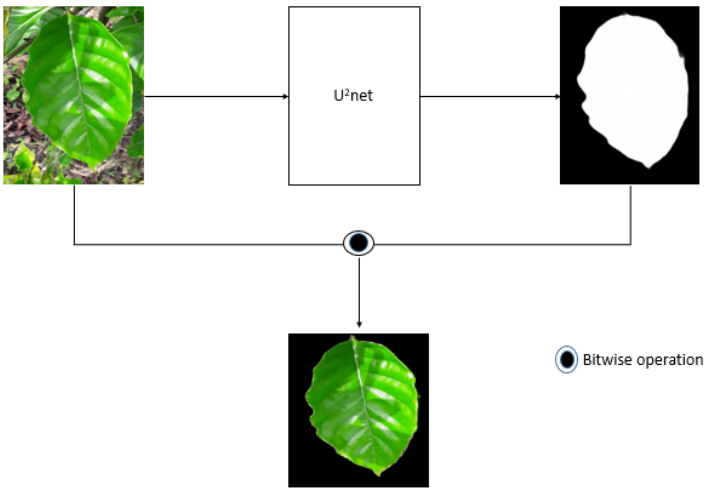
Figure 6. Segmented images using u 2 net.